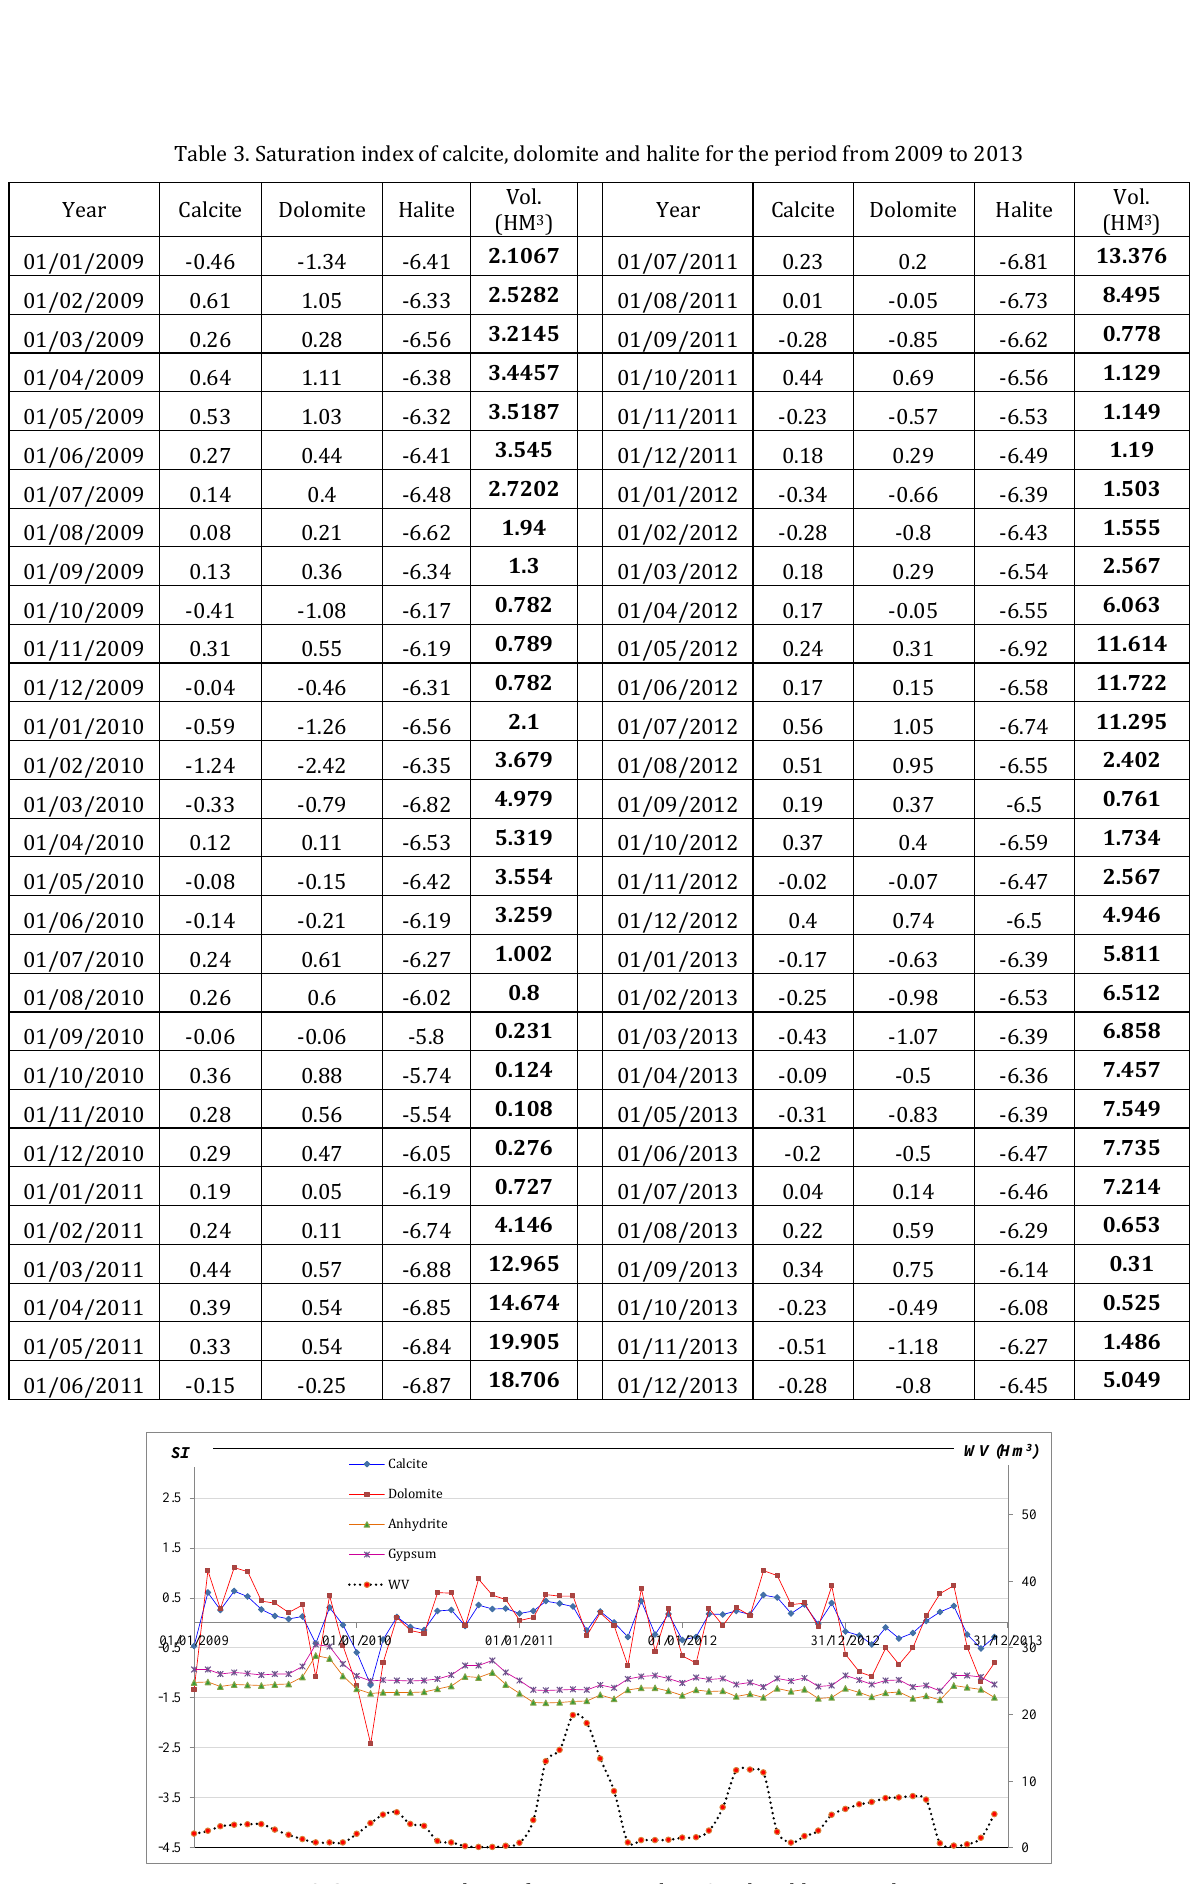
Fig. 9. Saturation indices of some minerals in Oued Fodda water